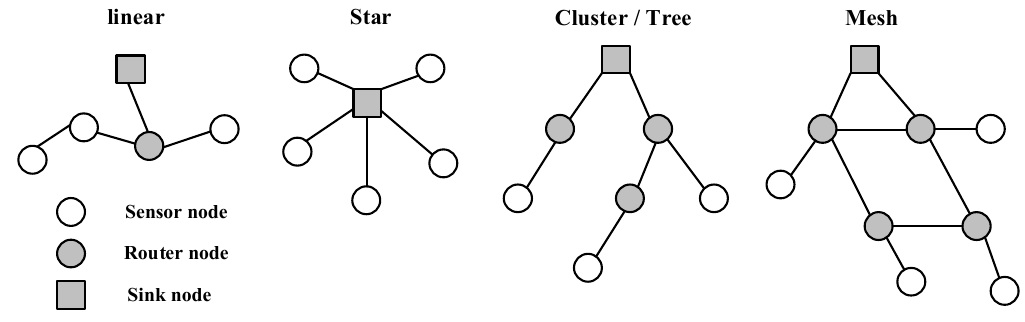
Figure 3. Typical wireless sensor network topologies.